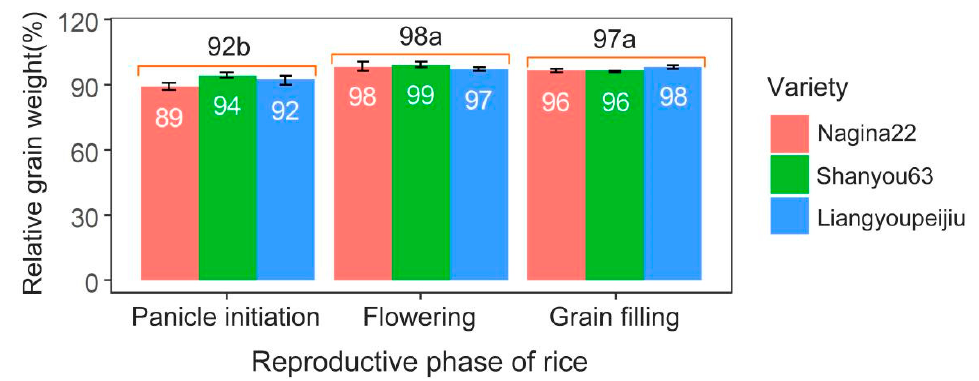
Figure 1. Effects of heat stress on rice grain weight during the panicle initiation, flowering, and grain-filling stages. Data originated from a location experiment repeated for 5 years [6] at Huazhong Agricultural University, Wuhan, China (30 ◦ 29 (cid:48) N, 114 ◦ 22 (cid:48) E). Heat treatments were imposed at panicle initiation, flowering, and grain-filling for 15, 7, and 30 days, respectively.